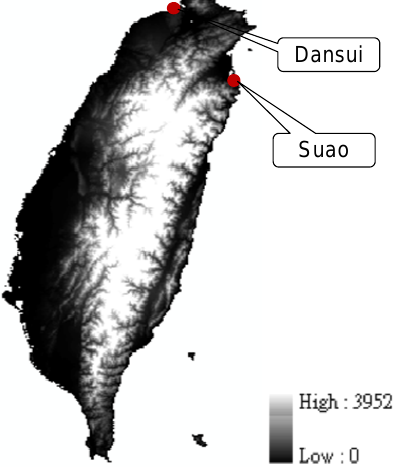
Figure 1. The study area showing the elevation levels and locations of two rain gauge stations used for verification of the TDVI